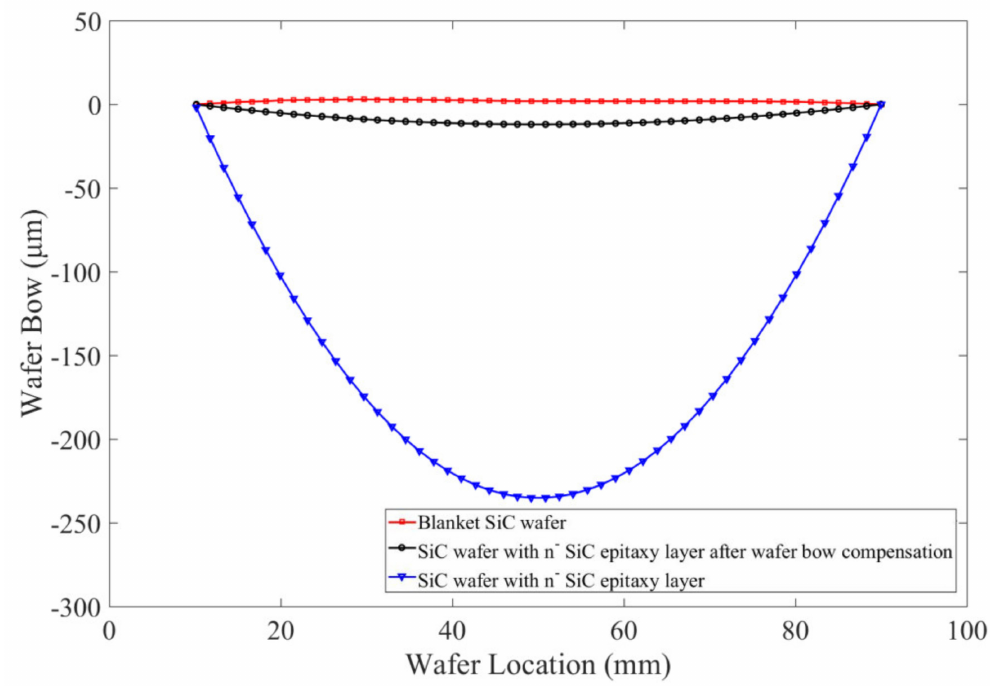
Figure 7. Pre − bonding wafer bow based on wafer curvature measurement.